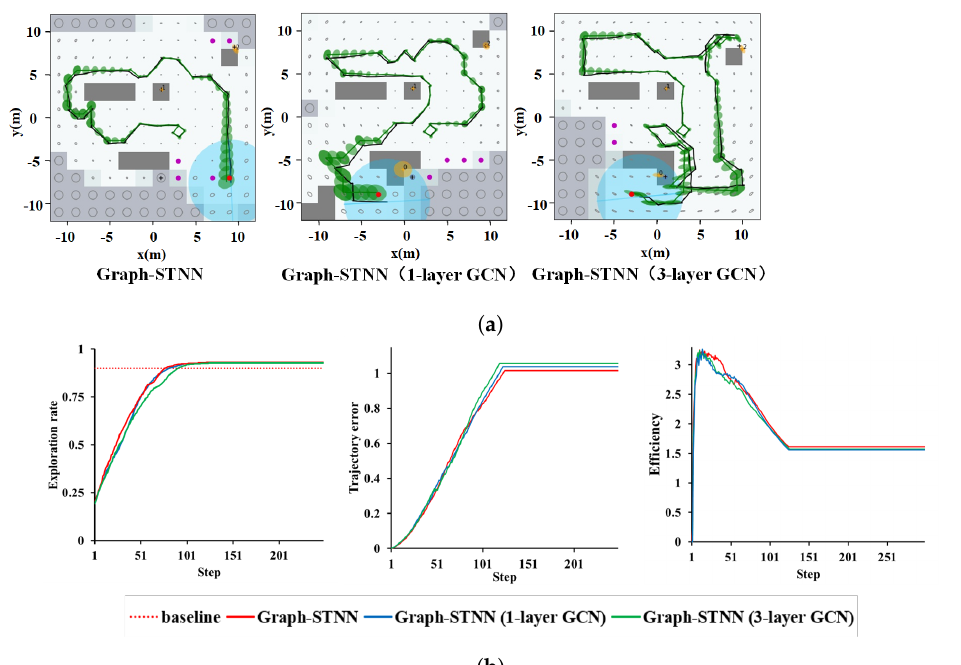
Figure 8. The test results of Graph-STNN with different-layer GCN in the spatial encoder of 50 explo- ration trials, with the same randomly initialized landmarks and robot start locations, on 20 m × 20 m maps (the results shown are plotted per time-step of the simulation). ( a ) One of the test result of 50 exploration trials. ( b ) Average exploration rate (left), trajectory error (middle), and exploration efficiency (right).